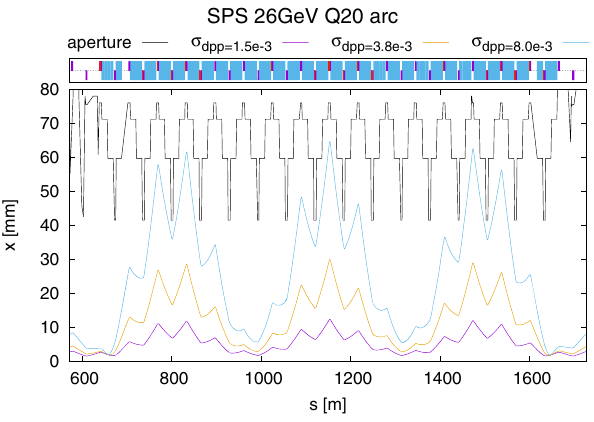
FIG. 2. Momentum beam size calculated as D x σ three values of momentum offset for the Q20 optics: one standard deviation (purple), bucket height (orange) and momentum cut (blue). Mechanical aperture from the machine model is given in